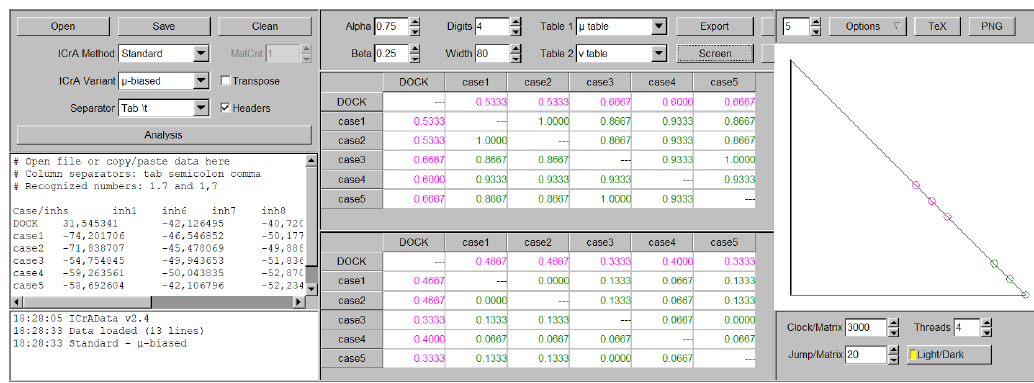
Fig. 4. Results from ICrA applied to